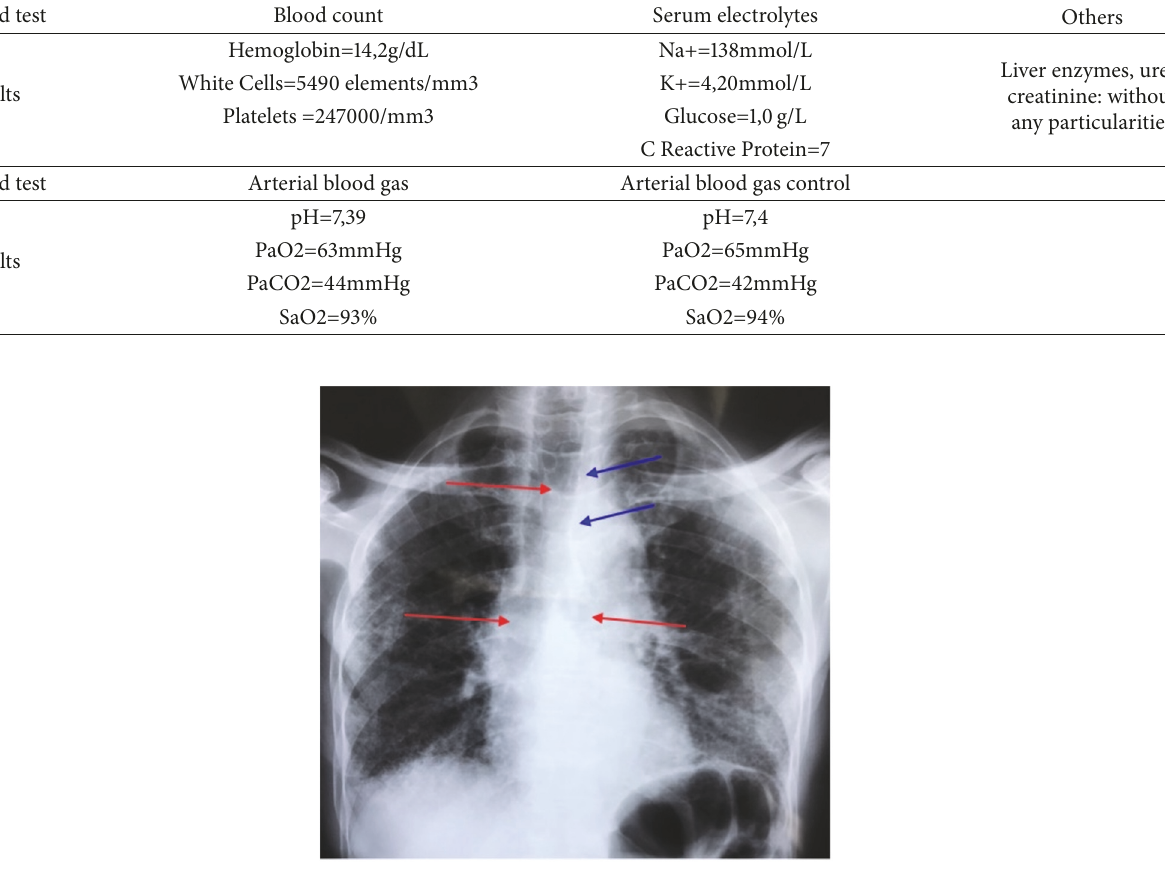
Figure 1: Chest X-ray showing tracheal and proximal bronchi dilation (red arrows) and pneumomediastinum (blue arrows).